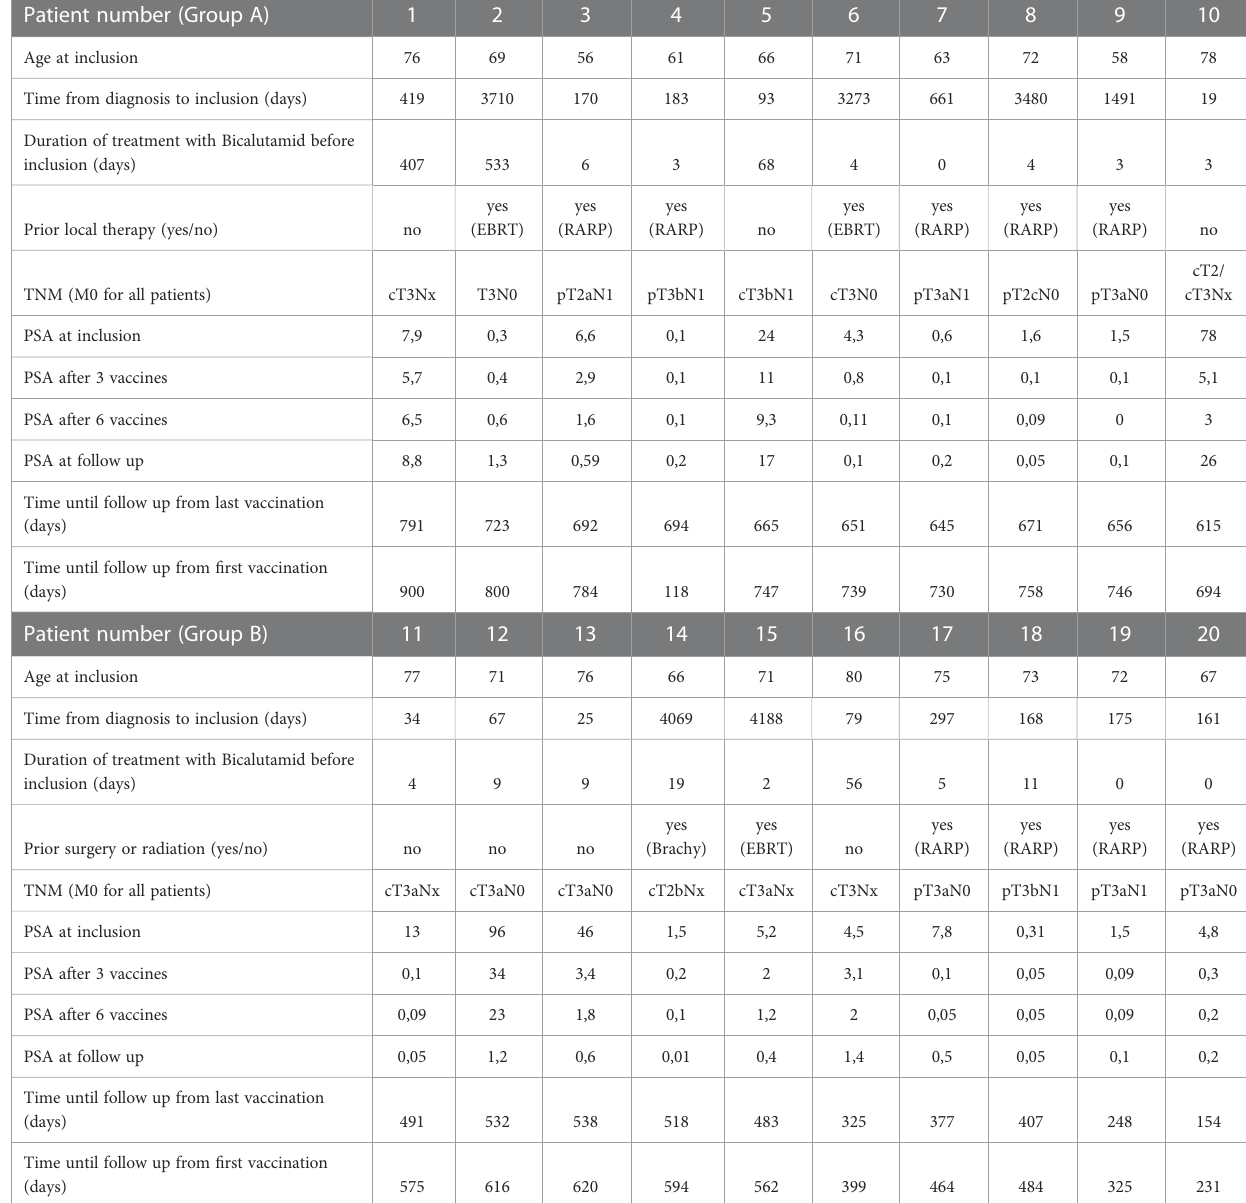
TABLE 1 Individual data for all patients in the